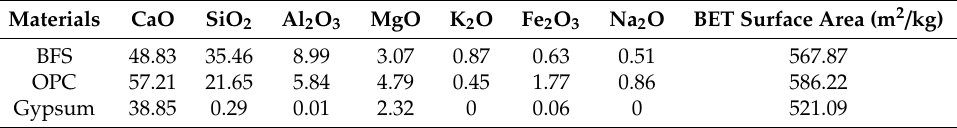
Table 1. Main components of raw materials / wt. %.